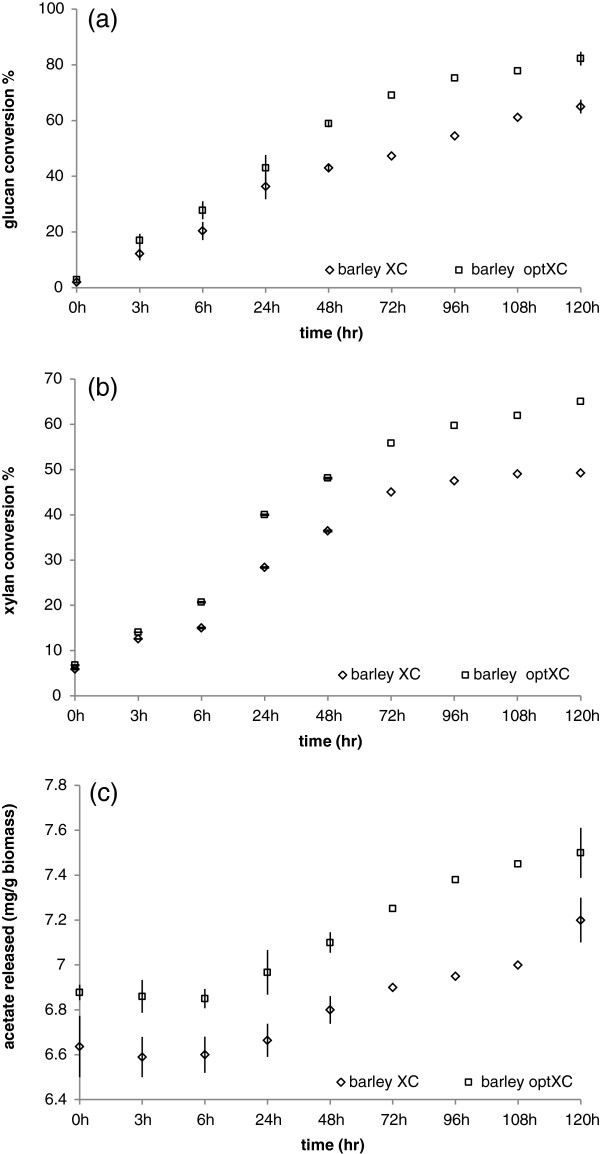
Glucose conversion (a), xylose conversion (b) and acetate released (c) from pretreated barley at 2% biomass load over 120 h of incubation with 15 mg/g of enzyme. Error bars represent SD of the mean (n = 8).